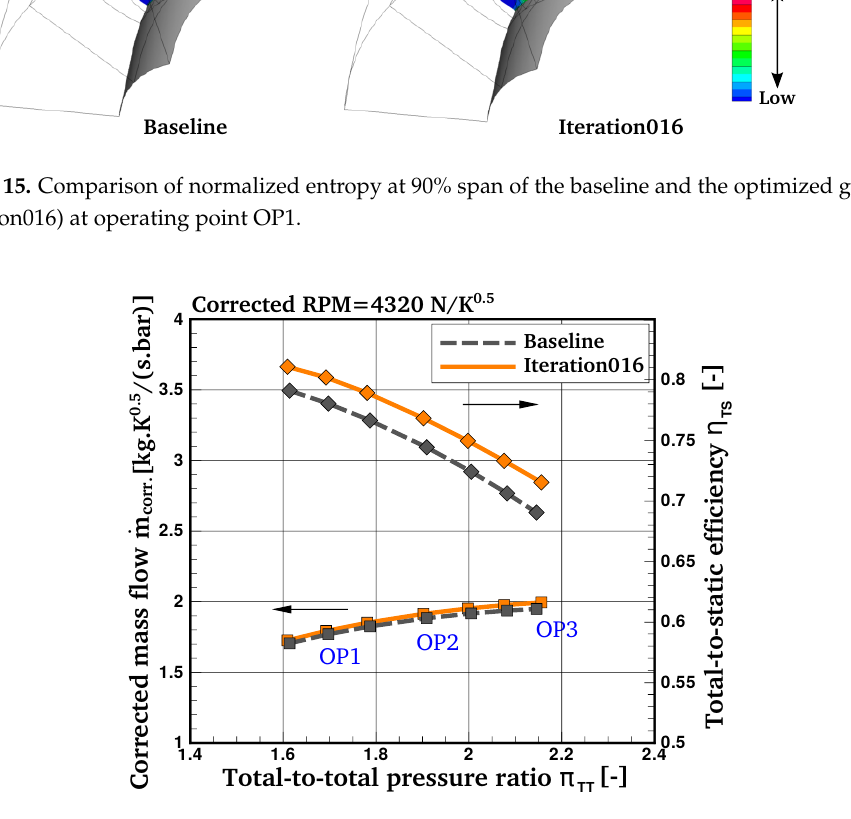
Figure 16. Performance map of the baseline turbine wheel and the optimized geometry